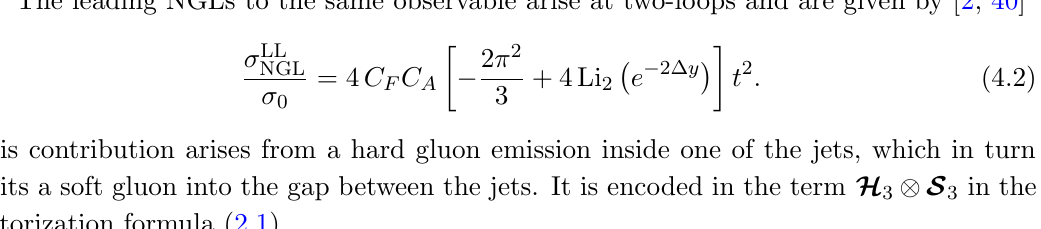
Figure 3 . Left: two-loop global and non-global coe(cid:14)cients as a function of the gap size (cid:1) y . Right: comparison of the LL resummation and (cid:12)xed-order results up to four loops, for (cid:1) y = 1. The leading NGLs to the same observable arise at two-loops and are given by [2,